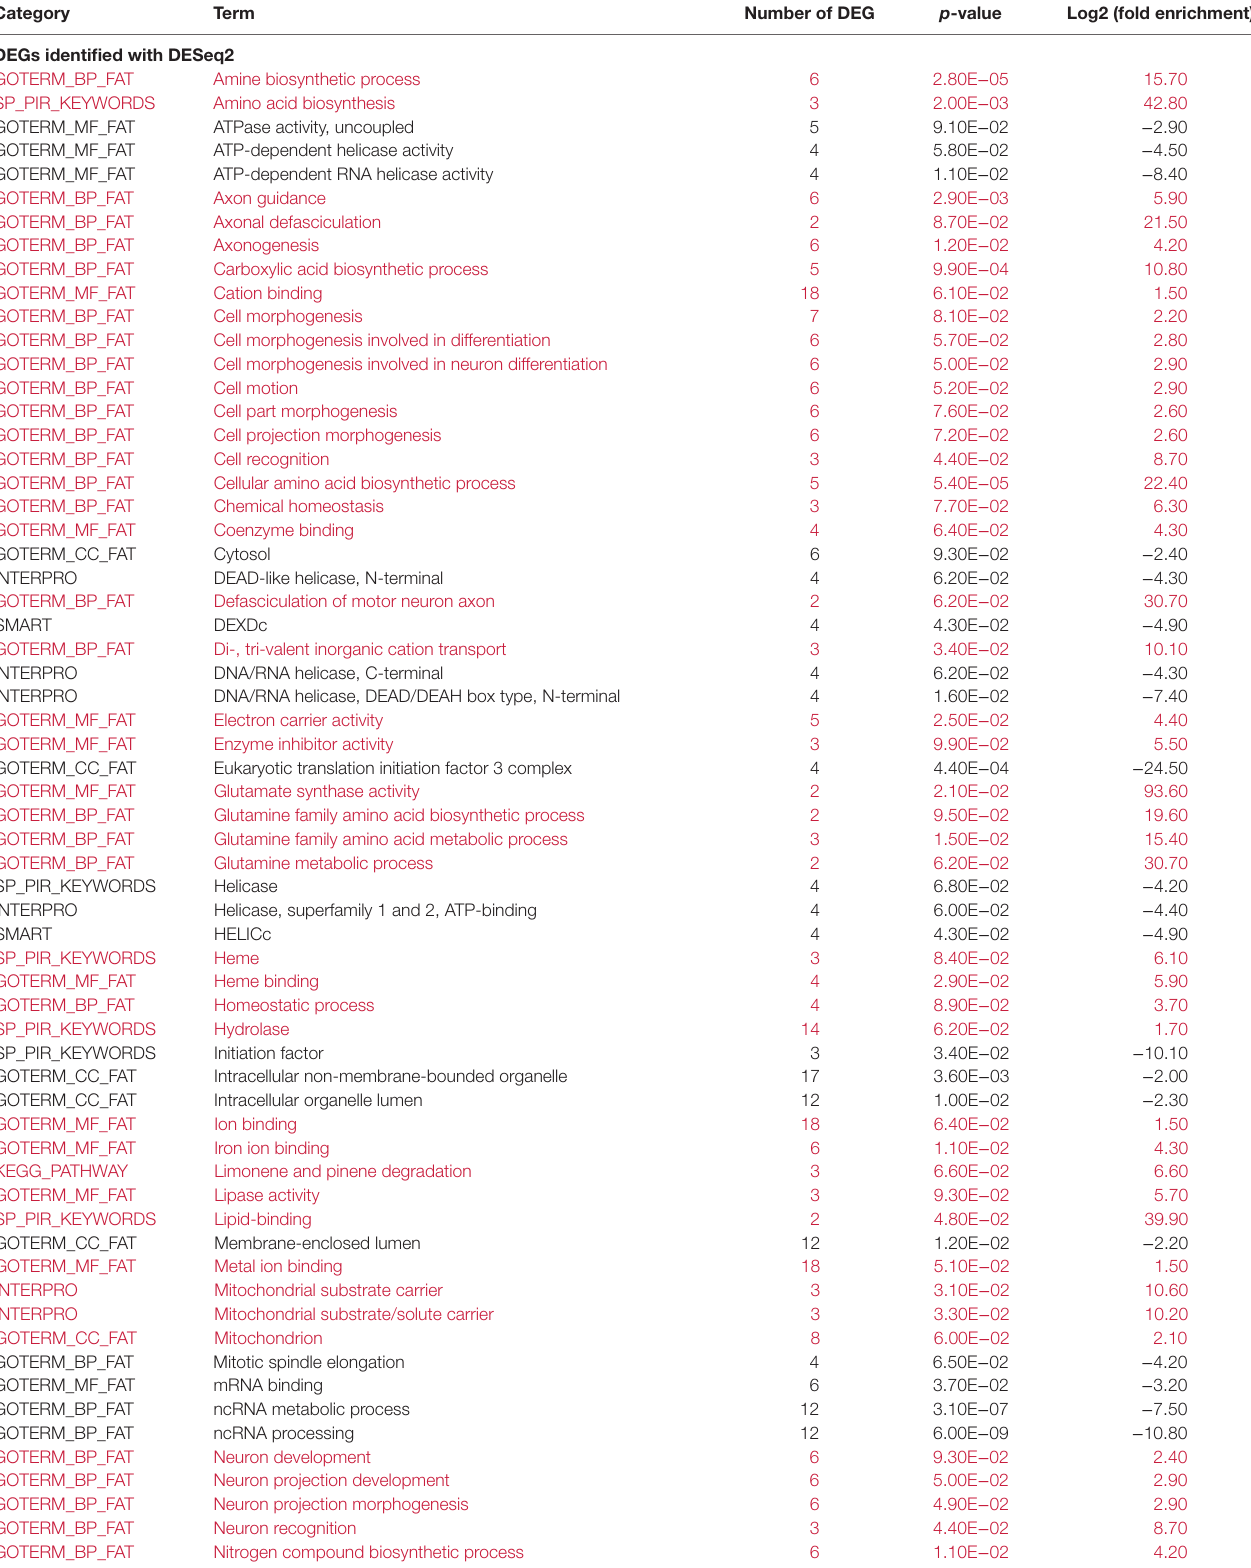
Table 6 | Functional annotation of differentially expressed genes (DEGs). category Term number of Deg Degs identified with Deseq2